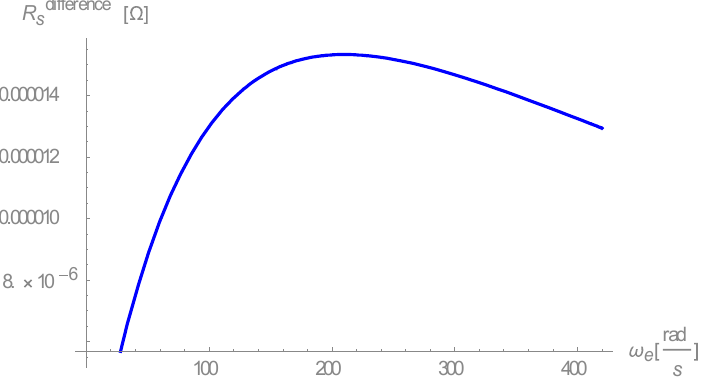
Figure 3. The difference between Equation (29) and the equation given in Reference [1], for the critical resistivity.